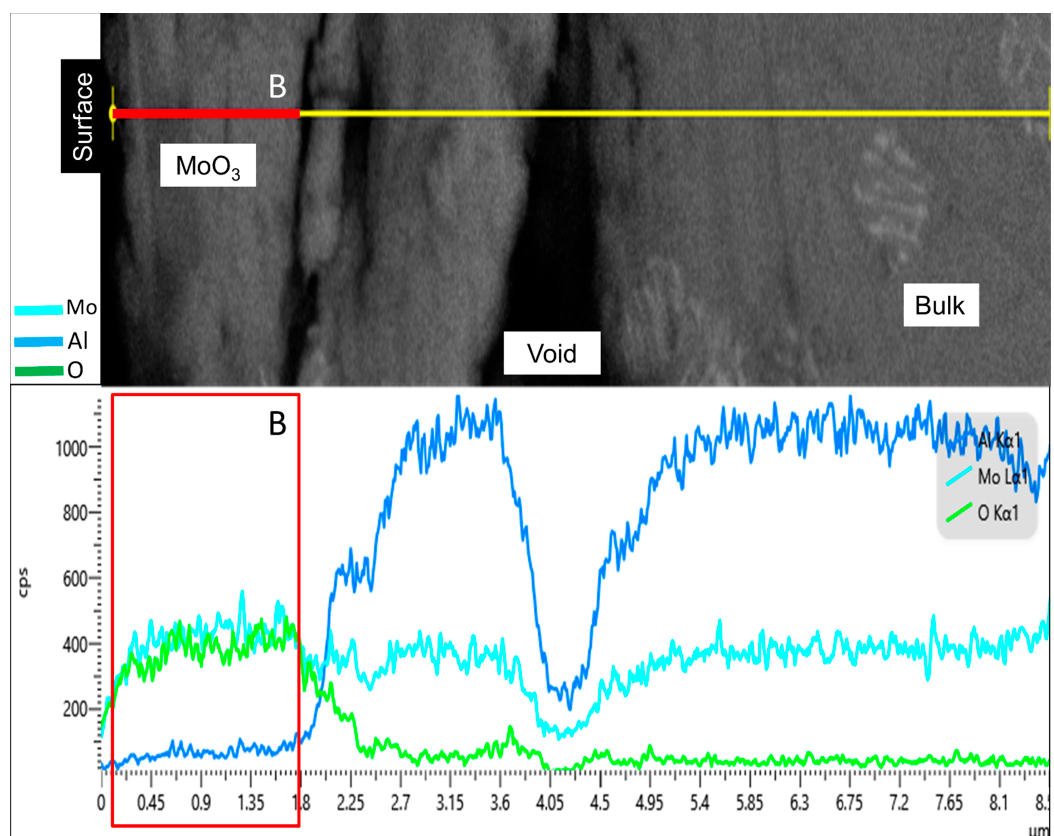
Nanomaterials 2021 , 11 , x FOR PEER REVIEW Figure 9. EDS line scan of DS_1h: cyan for Mo, blue signal for Al and green for O.